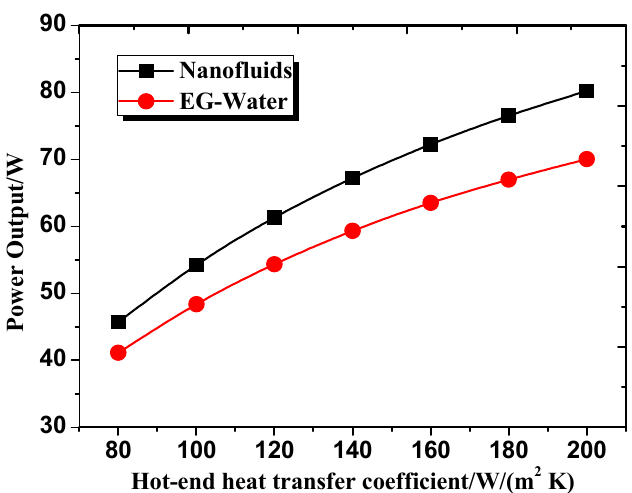
Figure 7. Power output varies with hot side heat transfer coefficient of the TEMs under Cu-EG nanofluid and EG-W as coolants for the cold side of the TEMs.